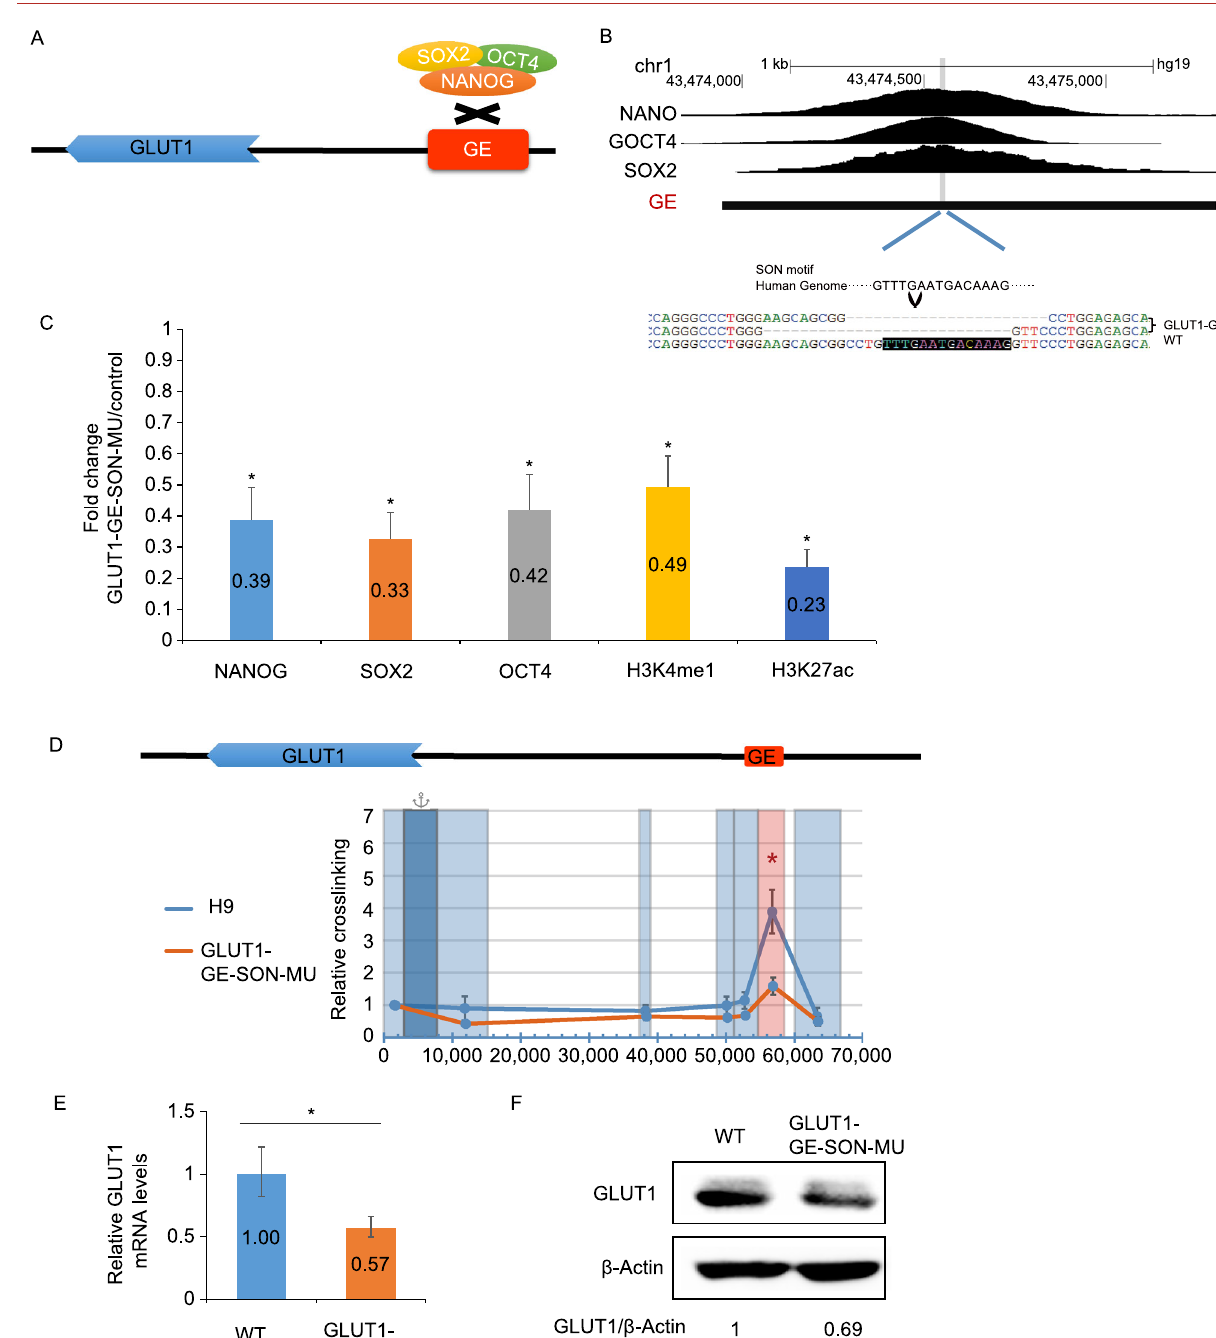
Figure 3. SON-binding motif within GE is required for GE activity in activating GLUT1 expression. (A) Schematic strategy to disrupt the SON binding site within GE. (B) Identi fi cation of the core binding sequence of the SON binding site based on the ChIP-seq data of SON in hESCs and disruption of the SON binding motif in hESCs. The sequences of GLUT1-GE-SON-MU hESCs are shown below, and the binding motif of SON is shaded black. (C) The disruption of the SON binding motif within GE in hESCs reduced the binding of SON to GE and the enhancer-speci fi c epigenetic signature of GE as con fi rmed by ChIP-qPCR assay. Data represent mean + SEM. n = 3. (D) The disruption of the SON binding motif reduced the long-range interaction between the promoter and GE of GLUT1. The GLUT1 promoter is indicated by dark blue and target restriction fragments light blue. GE-containing fragment is indicated by red box. Data represent mean ± SEM. n = 3. * P < 0.05. (E) The disruption of the SON site reduced the mRNA levels of the GLUT1 gene. Data represent mean ± SEM. n = 3. (F) The disruption of the SON site reduced the protein levels of GLUT1 in